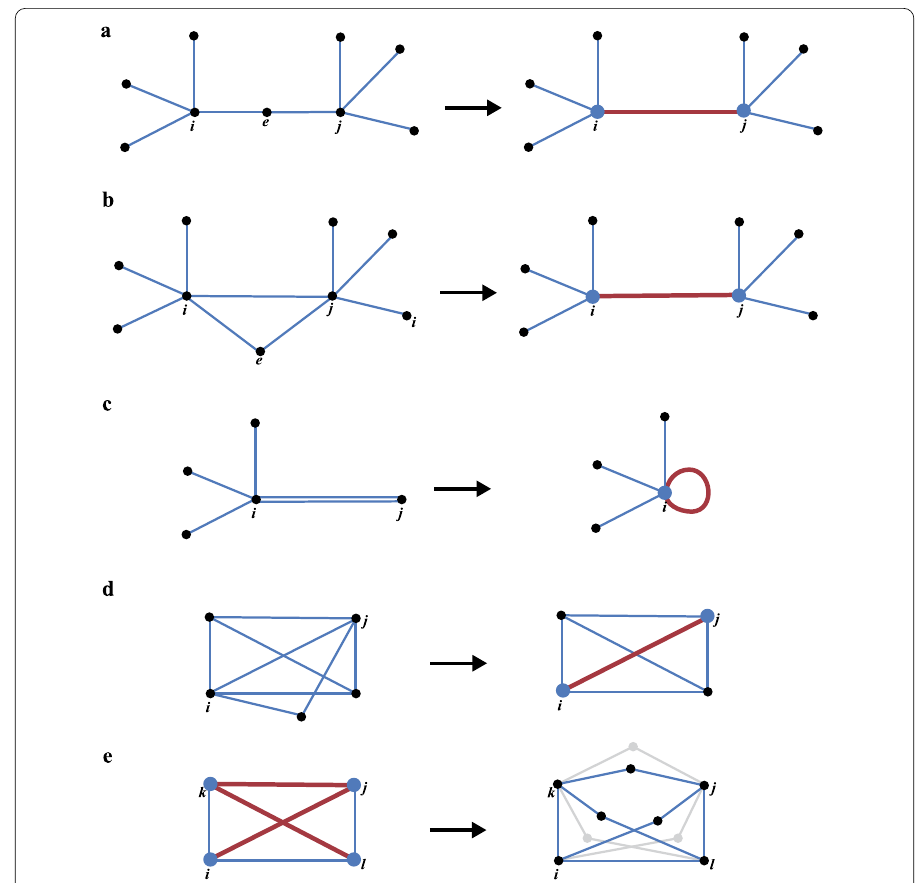
Figure 2 Explicit examples of the reduction procedure (Step 1). ( a ) Replacement of the 2-degree node e and its edges by a simple (red) edge. ( b ) After elimination of node e , the resulting multiedge is replaced by a simple (red) edge. ( c ) After the elimination of the 2-degree node j , a (red) self-loop appears that is also discarded. ( d ) After the reduction, the two paths joining i and j become a simple (red) edge. ( e ) After the detection of a true clique in the reduced network (called reduced clique), the complete cycles connecting their member nodes are determined in Step 3, restoring all the original members of the group. The right-hand side shows what is called an “embedded clique” in the unreduced network. It is not a true clique but a group of intersecting cycles, and hence a candidate focus of suspicious